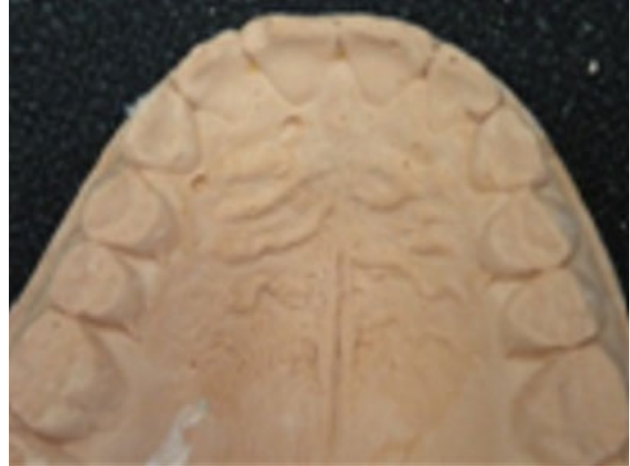
Fig. 2 - Cast with palatal rugae.